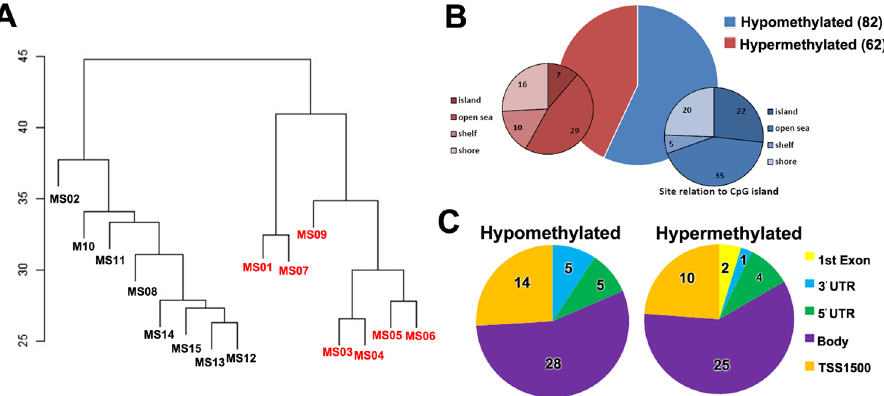
Figure 3. Global methylation profiles are different between myelinated and demyelinated MS hippocampus. Global DNA methylation was assessed using the Illumina 450 K array. Resultant clustering analysis shows that the MS demyelinated samples (shown in red) are separated from MS myelinated samples ( A ). Compared to myelinated MS hippocampus, 144 DMPs (62 hyper-methylated, 82 hypo-methylated) were identified in MS demyelinated hippocampus ( B ). Localization of these DMPs based on CpG islands, flanking CpG Islands (CGIs) (shores and shelves; 2–4 kb from CGIs), and open sea (non-related to CpGs) are shown ( C ). DMPs mapped onto genomic features (‘1 st exon’, 3 ′ and 5 ′ UTRs, ‘body’ of the gene, within 1500 bp of the transcription start site (TSS) of well characterized genes (UCSD genome browser hg19) show differences between hypo- and hyper-methylated